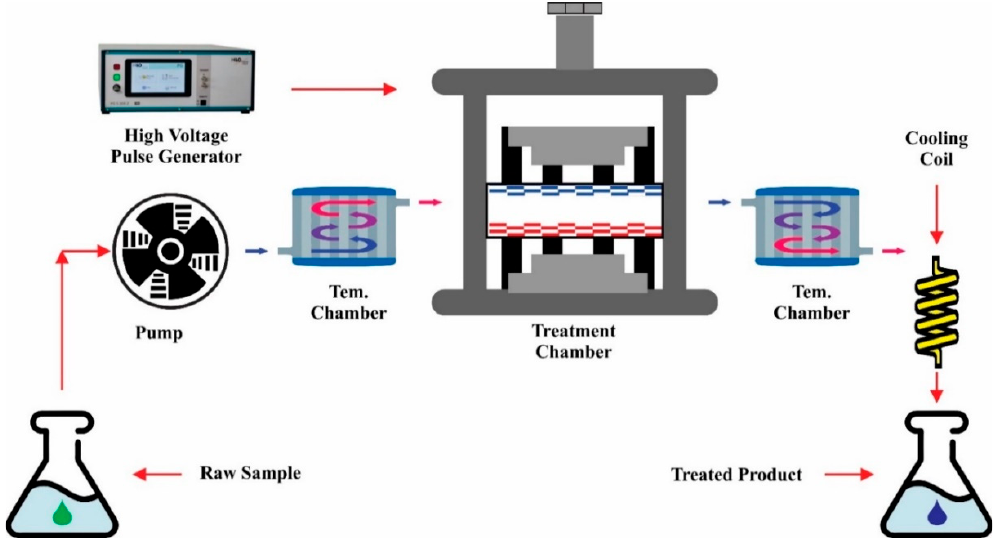
Figure 1. A representation of a pulsed electric field process (PEF) (Adapted from Ranjha et al., [20]). Food conductivity, chamber geometry, circuit parameters, the intensity of the elec- tric field, processing time, frequency, pulse shape, and the specific energy are all factors that influence the efficiency of the PEF process. [3]. Electric field strength, which is